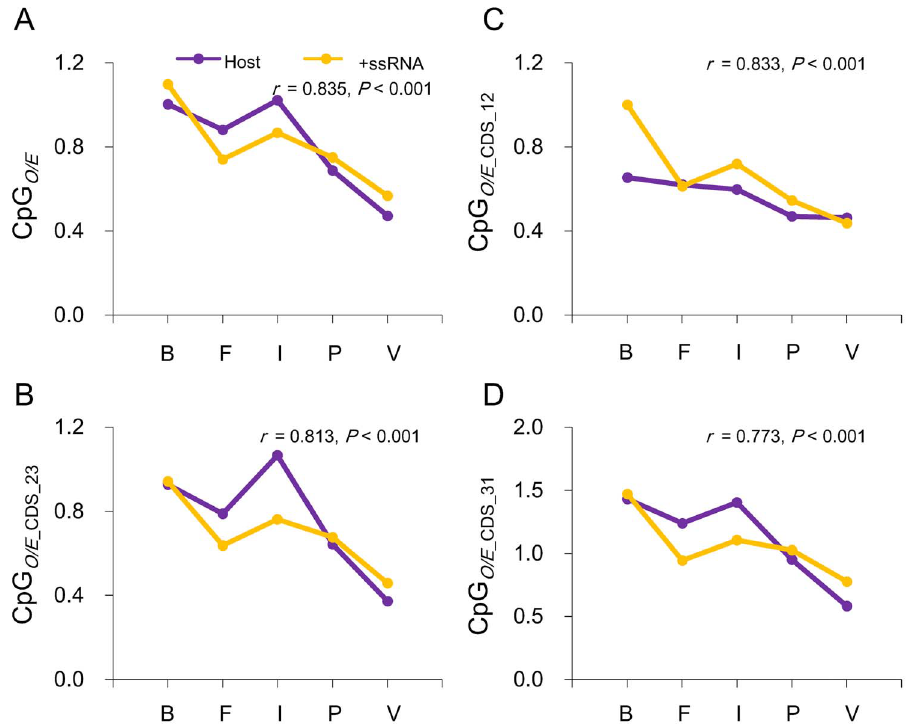
Figure 4. + ssRNA viruses mimic the CpG usage of their respective host. Correlation between + ssRNA viral and host’s mean CpG O/E ( A ), mean CpG O/E _CDS_12 ( B ), mean CpG O/E _CDS_23 ( C ), and mean CpG O/E _CDS_31 ( D ). The abbreviations at the bottom of each chart (B, F, I, P, and V) represent bacteria or bacterial-infecting + ssRNA viruses, fungi or fungus-infecting + ssRNA, invertebrates or invertebrate-infecting + ssRNA viruses, plants or plant-infecting + ssRNA viruses, and vertebrates or vertebrate-infecting + ssRNA viruses, respectively.